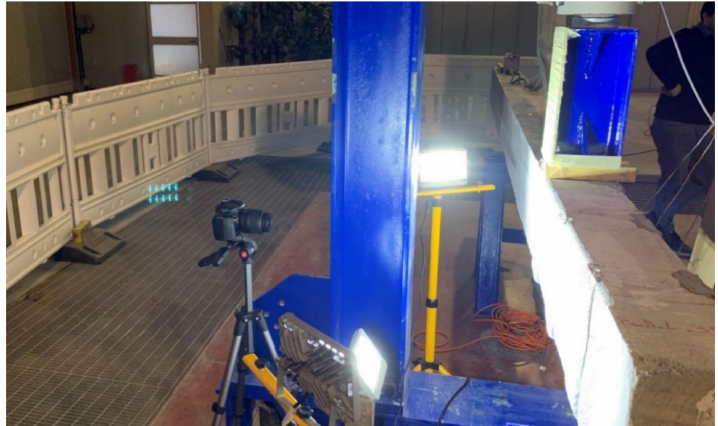
Figure 2. Digital Image Correlation (DIC) system adopted for strain